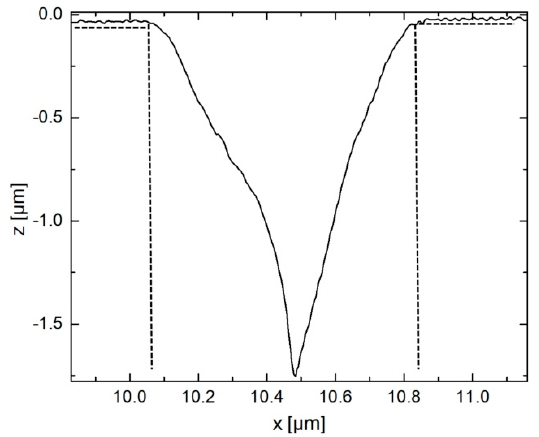
Figure 15. Imaging of the microprobe tip shape by measuring two successive sharp edge structures and cutting the measured profile at these points.